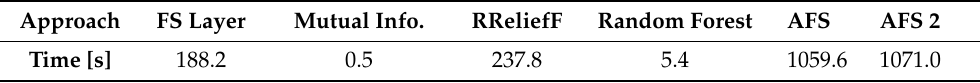
Table 17. Time duration for feature importance values generation (NGTP